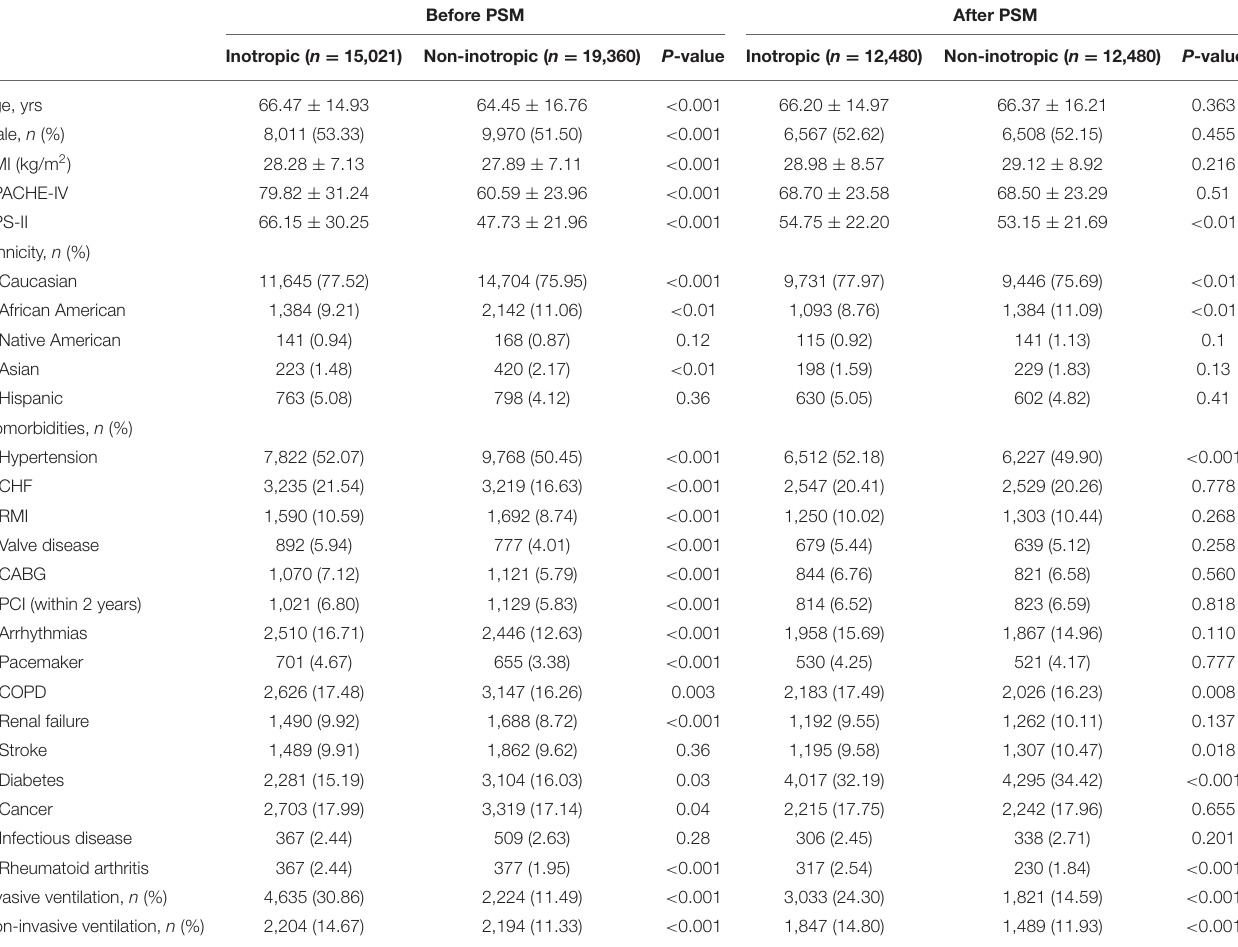
TABLE 1 | Baseline characteristics of before and after propensity score matching between patients receiving inotropic agent and patients not receiving inotropic agent. Before PSM After PSM Inotropic ( n = 15,021) Non-inotropic ( n = 19,360) P -value Inotropic ( n = 12,480) Non-inotropic ( n = 12,480) P